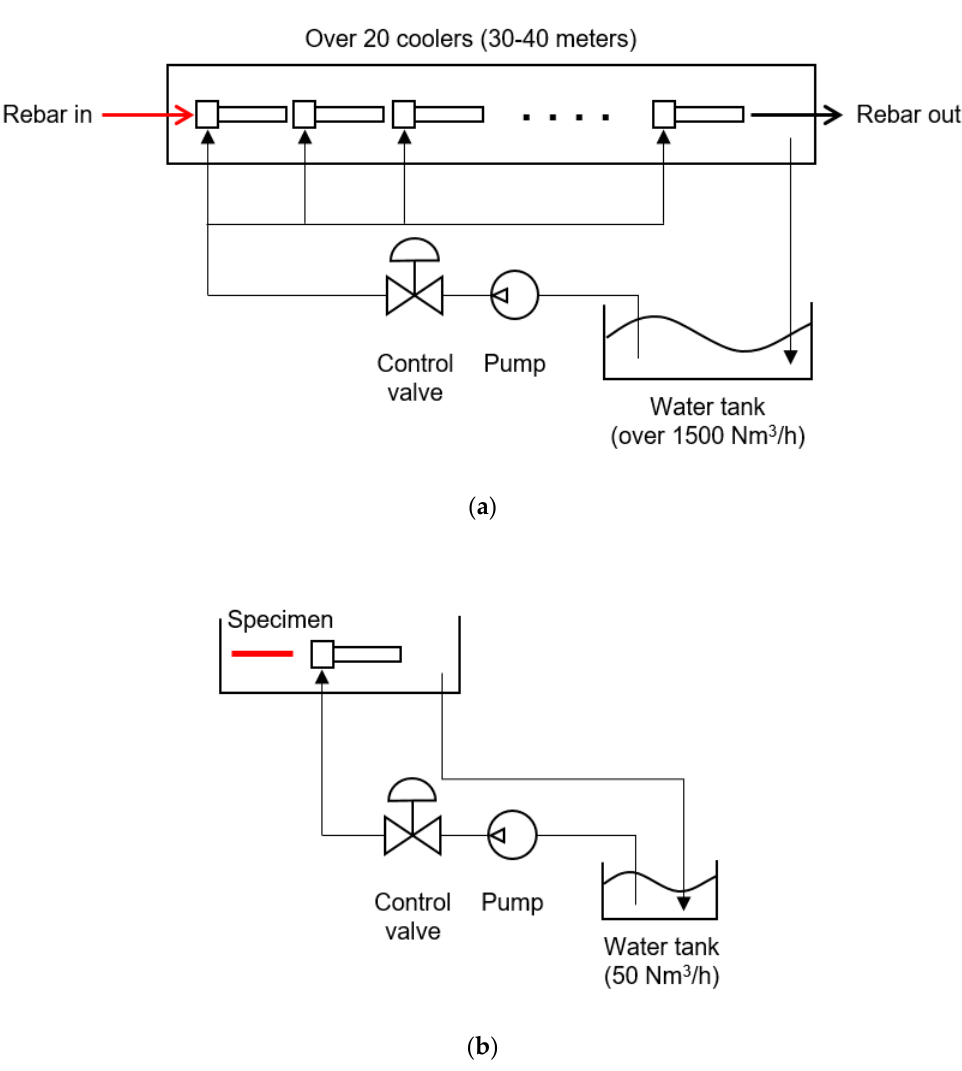
Figure 5. Similarity of cooling system for the Tempcore process: ( a ) production line; ( b ) TPS. To fabricate test specimens, a 50 kg ingot having 120 mm × 120 mm cross-section has been heated to 1150 °C in a vacuum induction furnace and plate rolled to 28 mm thickness. Then, square bars are cut from the as-rolled plate, and specimens having a 25 mm diameter and 360 mm length were machined from square bars by lathe. Figure 6 shows the sequence of fabrication of the test specimen.